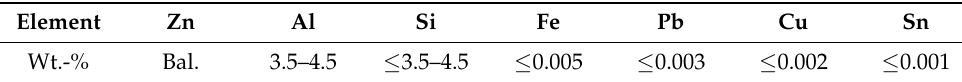
Table 1. Composition of the ZnAl4 wires used as feedstock material. Element